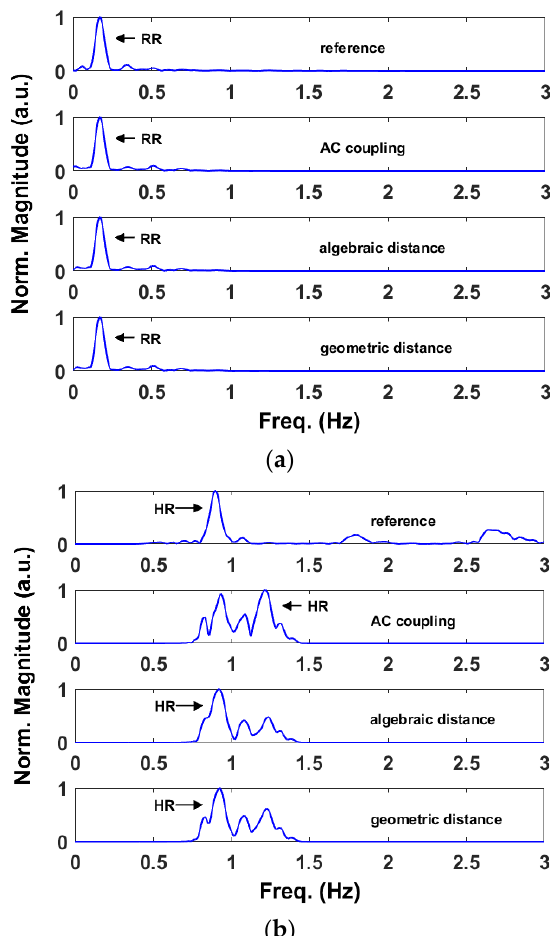
Figure 9. Example of baseband signals in the IQ plane obtained with the mmWave radar after applying the DC calibration methods. ( a ) Spectra obtained from the retrieved respiration signals. ( b ) Spectra obtained from the retrieved heartbeat signals.